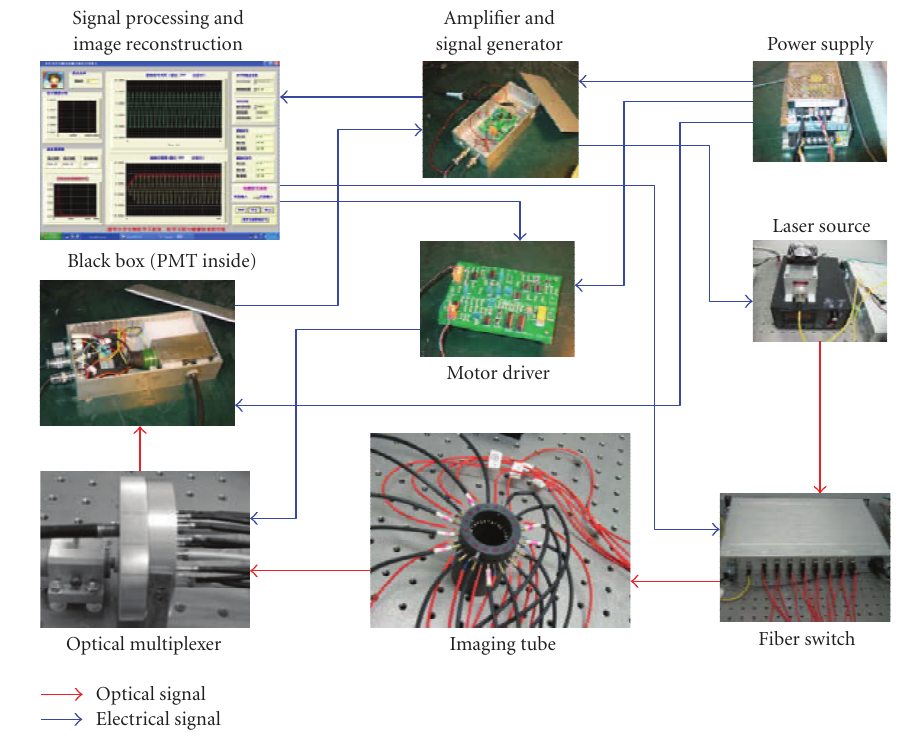
Figure 4: The practical imaging